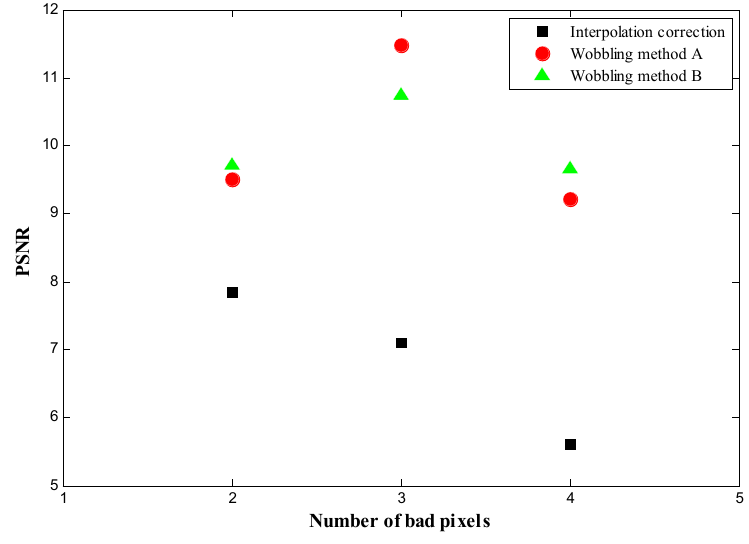
Table 2. SSIM of correction for background bad pixels.